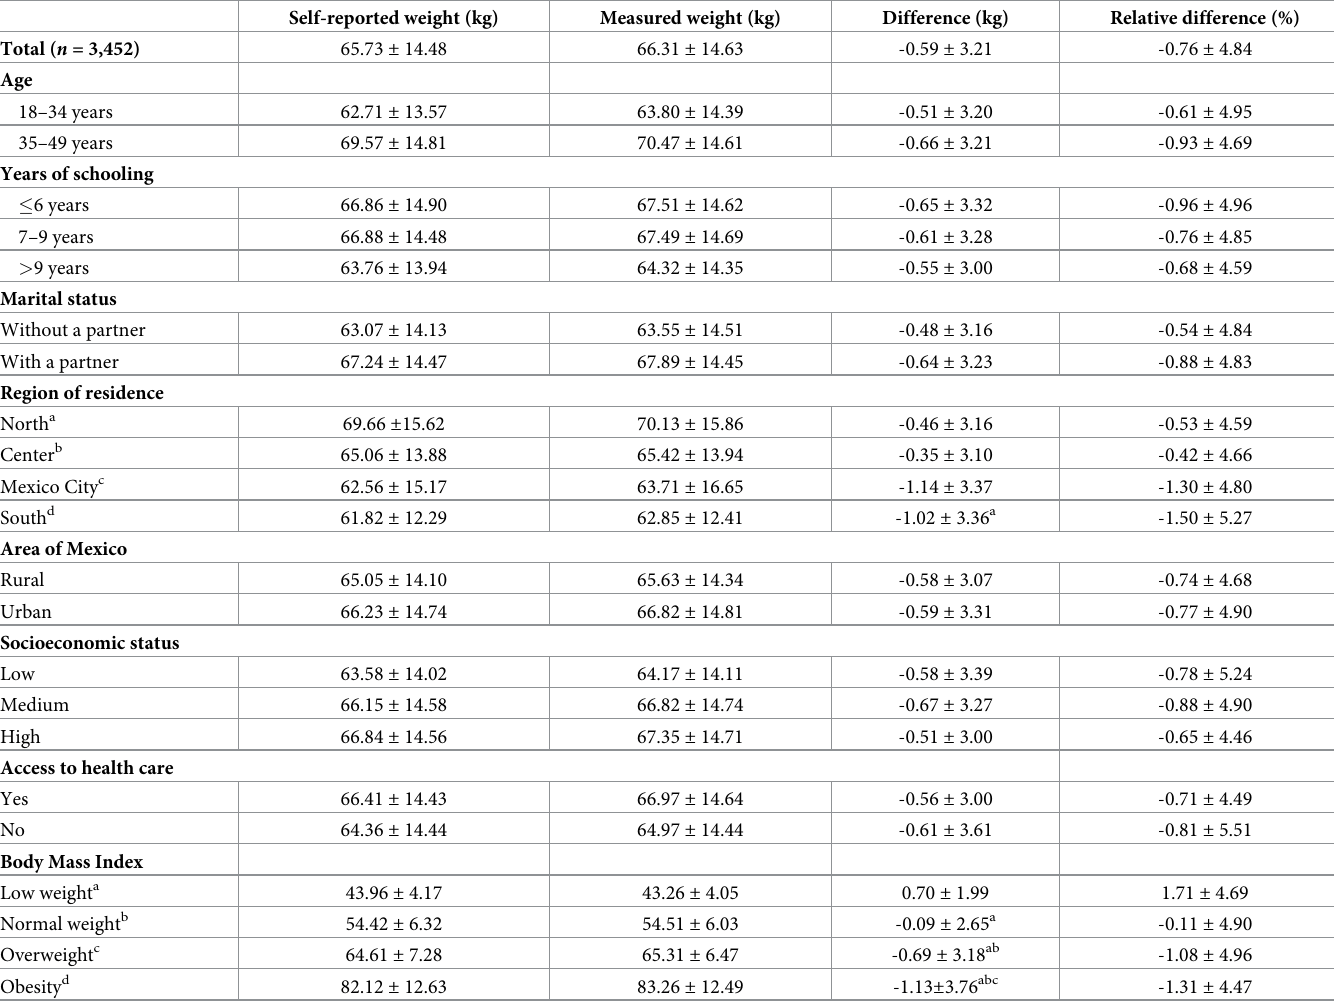
Table 2. Self-reported weight, measured weight, absolute difference and relative difference according to sociodemographic characteristics.